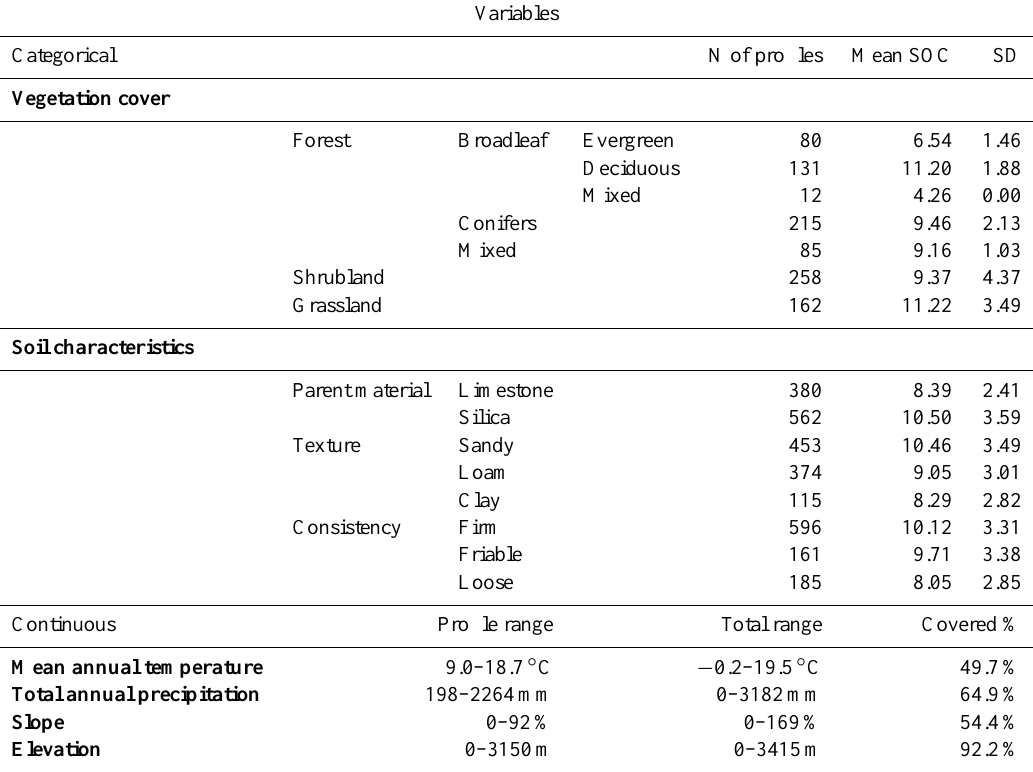
Table 1. Variables used in the model. For both categorical variables, vegetation cover (classified following the Corine Land Cover Map) and soil characteristics (based on geologic expert criteria), number of profiles, mean SOC values and the standard deviation of the mean are indicated. For each of the continuous variables, profile ranges, total map ranges and % of the total range covered by the profiles are indicated. The mentioned variables are shown in